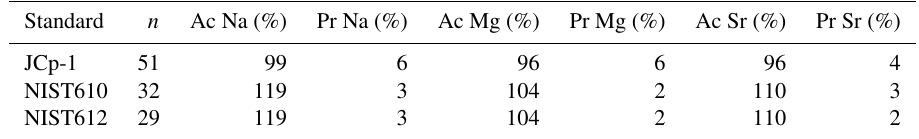
Table 2. Accuracies (Ac) and precisions (Pr) for Na, Mg and Sr for the various standards analysed.